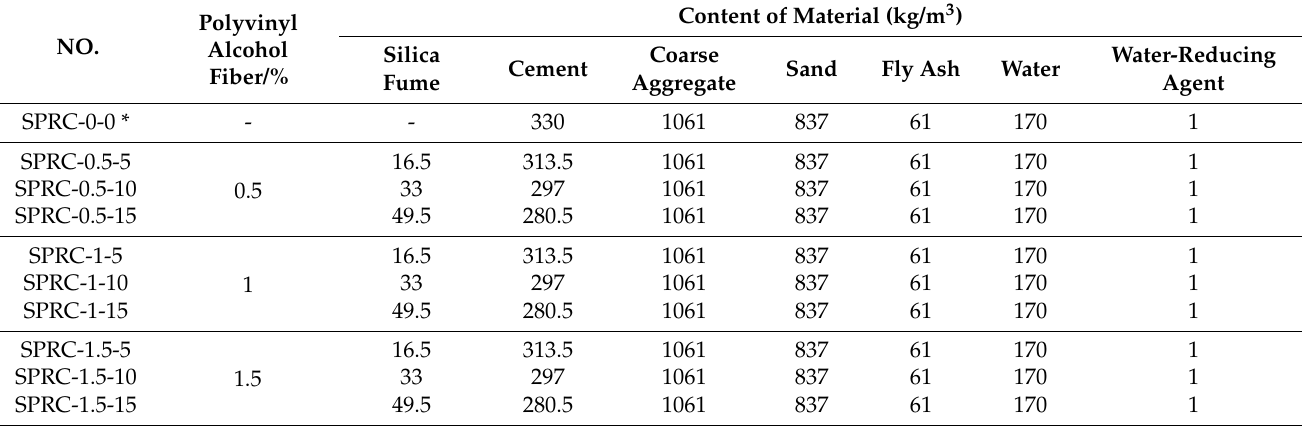
Table 2. Mix proportions of the designed